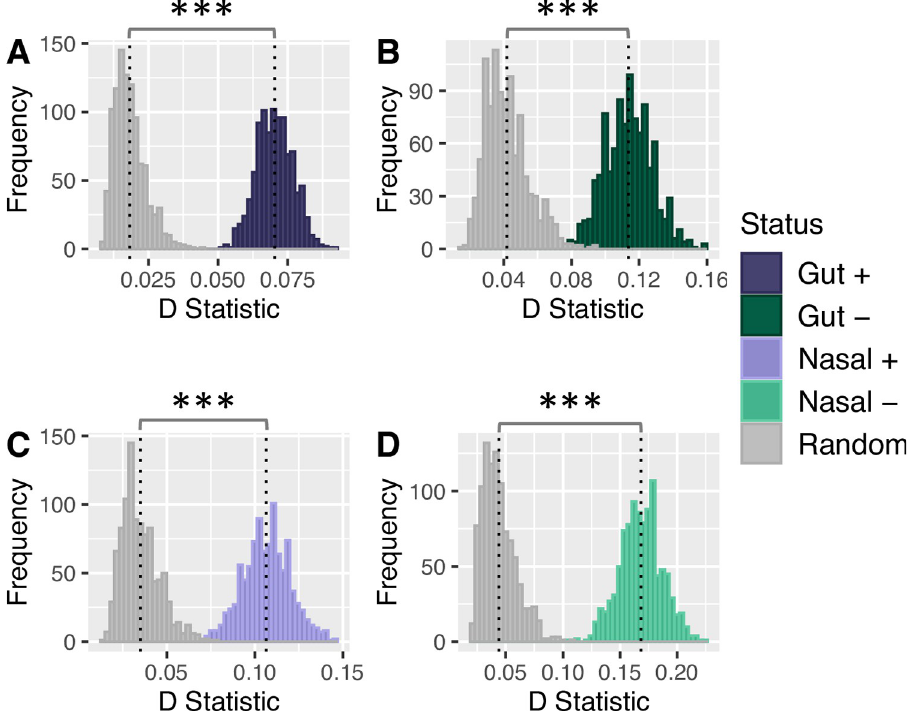
Fig 3. Gut and nasal microbiome features have significantly different pairwise distance distributions compared to null expectation. Microbial features that were significantly associated with clinical signs were separated into four groups A–D. For each group, the observed D statistic was calculated by comparing the observed pairwise distances against a random sampling of nodes using the KS test and is indicated by colored bars. A corresponding null set of D statistics, D’ , was generated by comparing pairwise distance distributions from two random sampling events on the phylogenetic tree and is indicated by grey bars. This was repeated for a total of 1,000 times for each case. The mean D and D’ statistic value is indicated by black dotted lines. Statistical significance between groups was assessed using the Wilcoxon Rank Sum Test. Mean D statistic for all selected features was significantly greater compared to null expectation ( p < 2.2 x 10 − 16